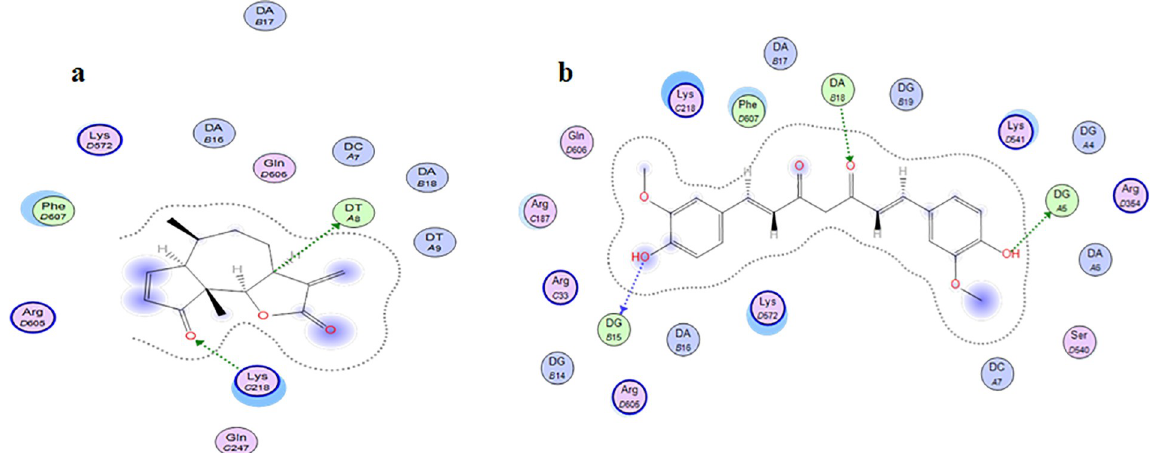
Fig 14. Binding modes of ambrosin (a) and curcumin (b) showing polar interactions with DNA bases within NF- κβ p65. DNA nucleotides are indicated by light green colors. Amino acids residues are blue pink in color. Hydrogen bonds are indicated as dotted arrows Hydrophobic interactions are highlighted in violet